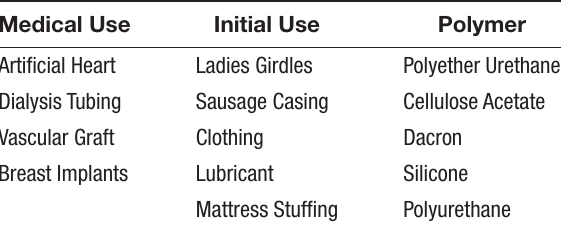
Table 2. Examples of Polymers in